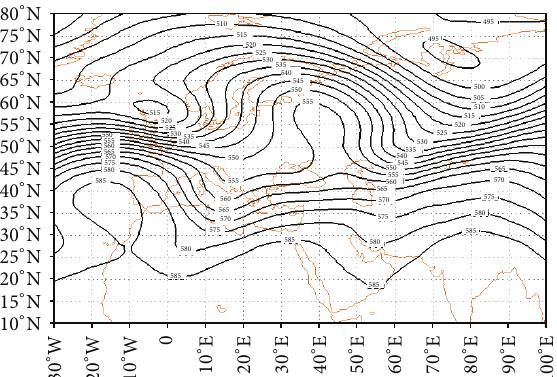
Figure 10: 500 HPa geopotential height level map.